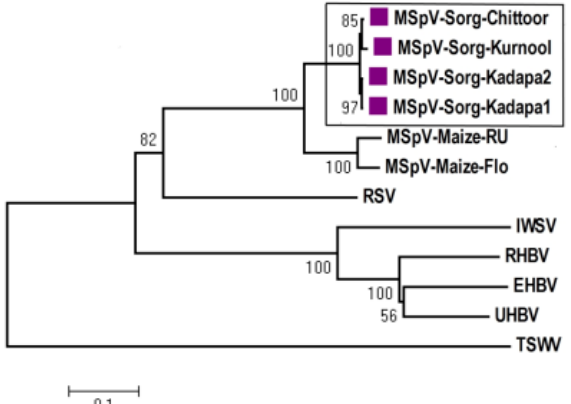
Figure 3. Phylogenetic tree based on the alignment of MSpV-Sorg sequences at complete RNA3 nucleotide level, constructed using MEGA version 4.0. The values at the forks indicate the number of trees that this grouping oc- curred after bootstrapping the data. The scale bar shows the number of substitutions per base. Virus acronyms: RSV, Rice stripe virus ; IWSV, Iranian wheat stripe virus ; RHBV, Rice hoja blanca virus ; EHBV, Echinochloa hoja blanca virus ; UHBV, Urochloa hoja blanca virus ; TSWV, Tomato spotted wilt virus. TSWV was included as an out group.